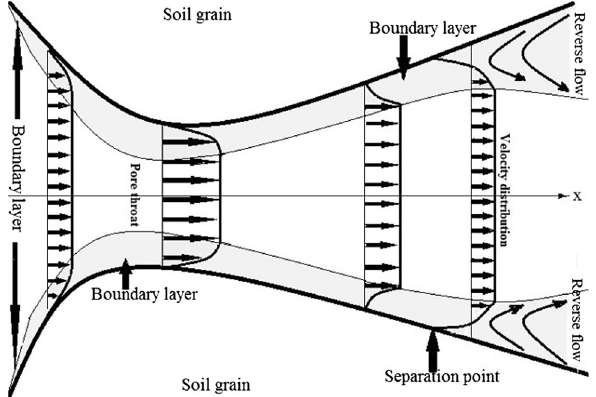
Fig. 1 Schematic illustration of the boundary layer in distorted capil- laries within two soil